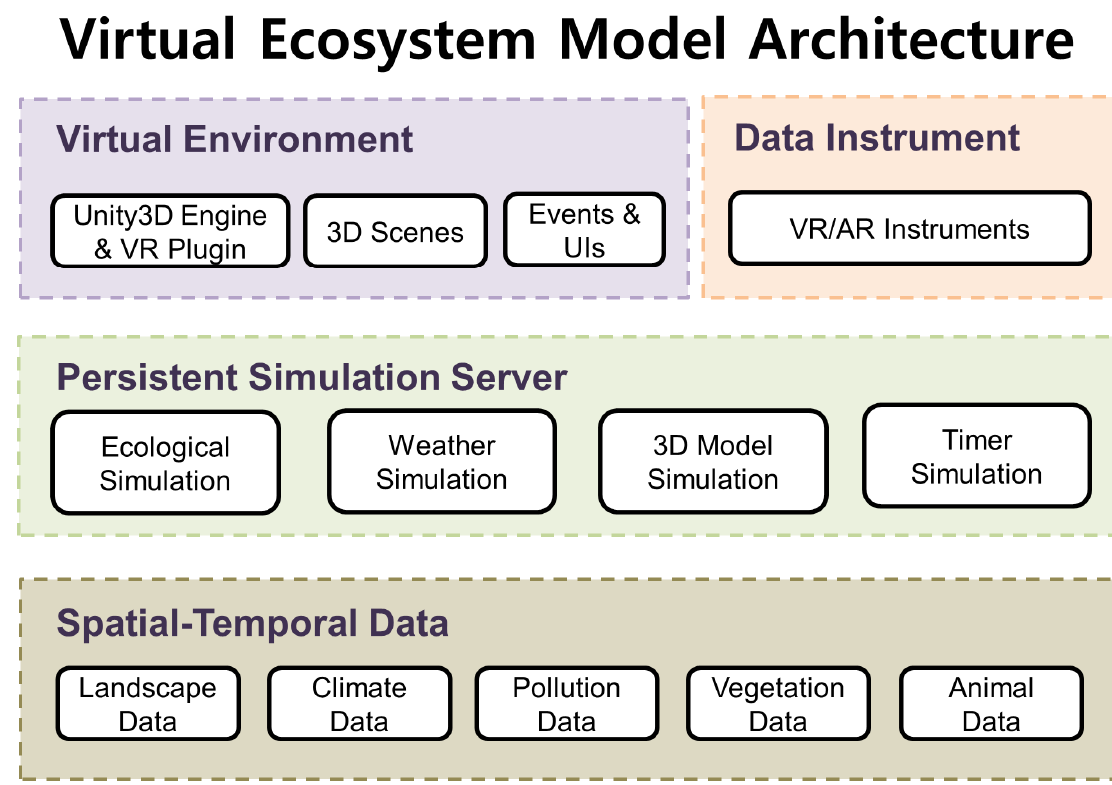
Figure 1. System architecture of virtual reality simulation based on virtual ecosystem model .